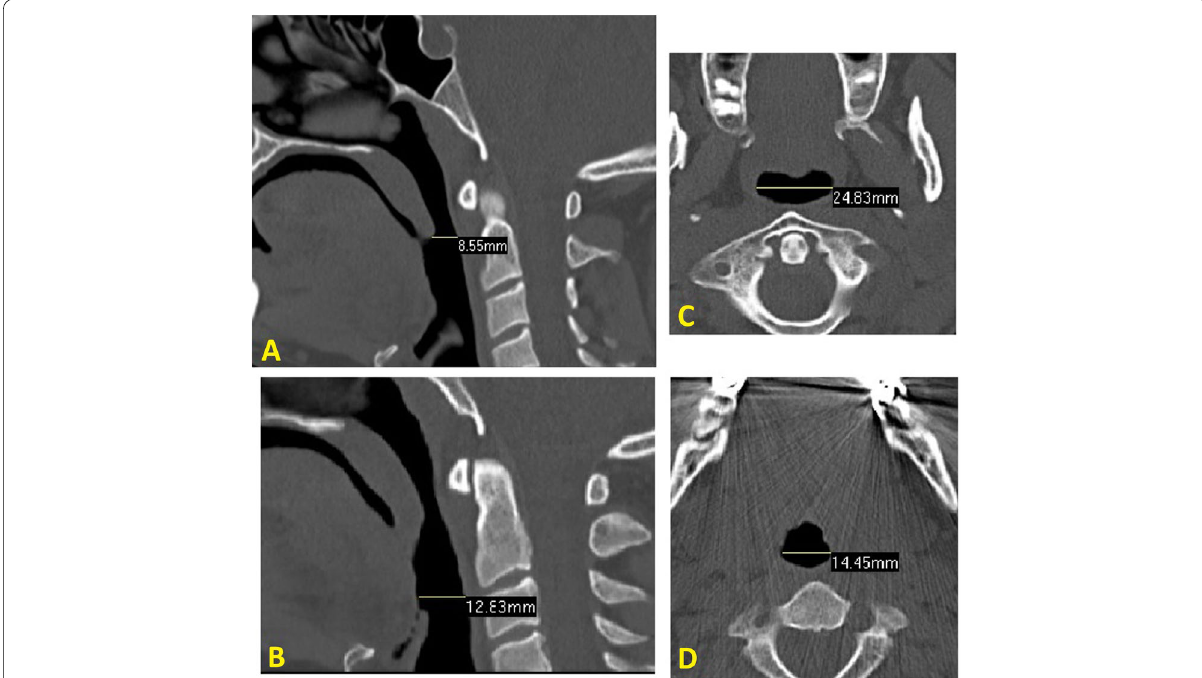
Fig. 1 Sagital CT shows the measurement of the anteroposterior dimensions at the retroplatal ( A ) and the retroglossal ( B ) levels. Axial CT shows measurement of the transverse diameter at the retroplatal ( C ) and the retroglossal ( D ) levels